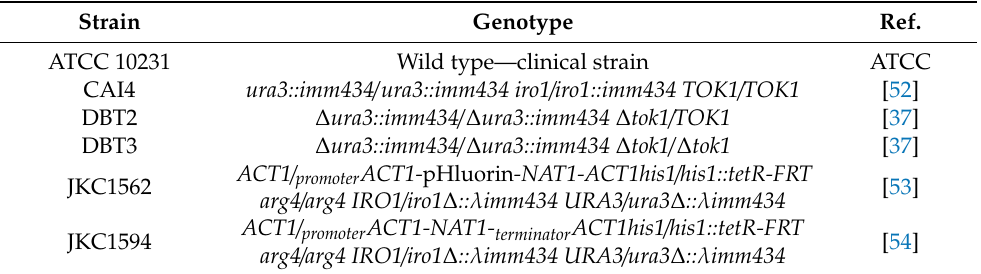
Table 1. Genotypes and origin of Candida albicans strains used in this